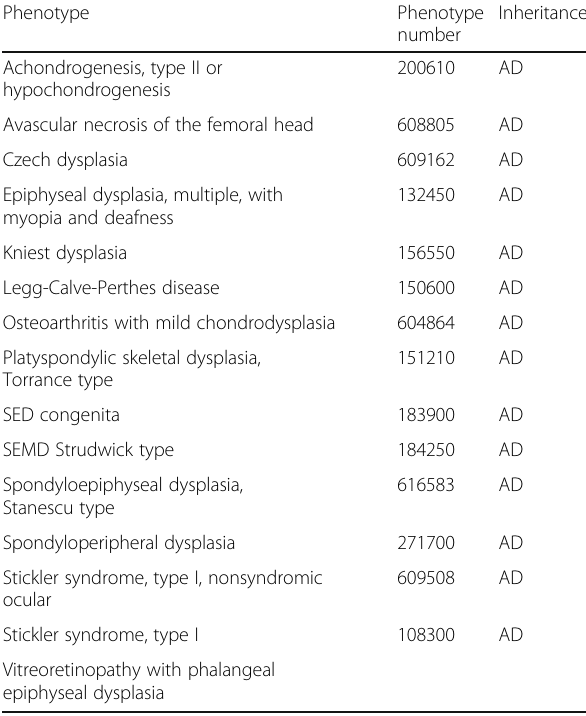
Table 1 Phenotypes related to mutations in